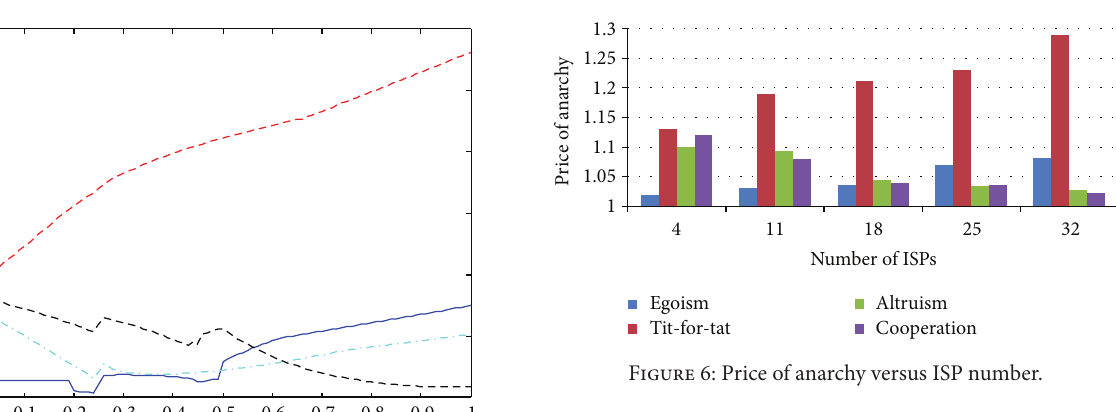
pattern and has near-optimal PoA values in high popularity range.